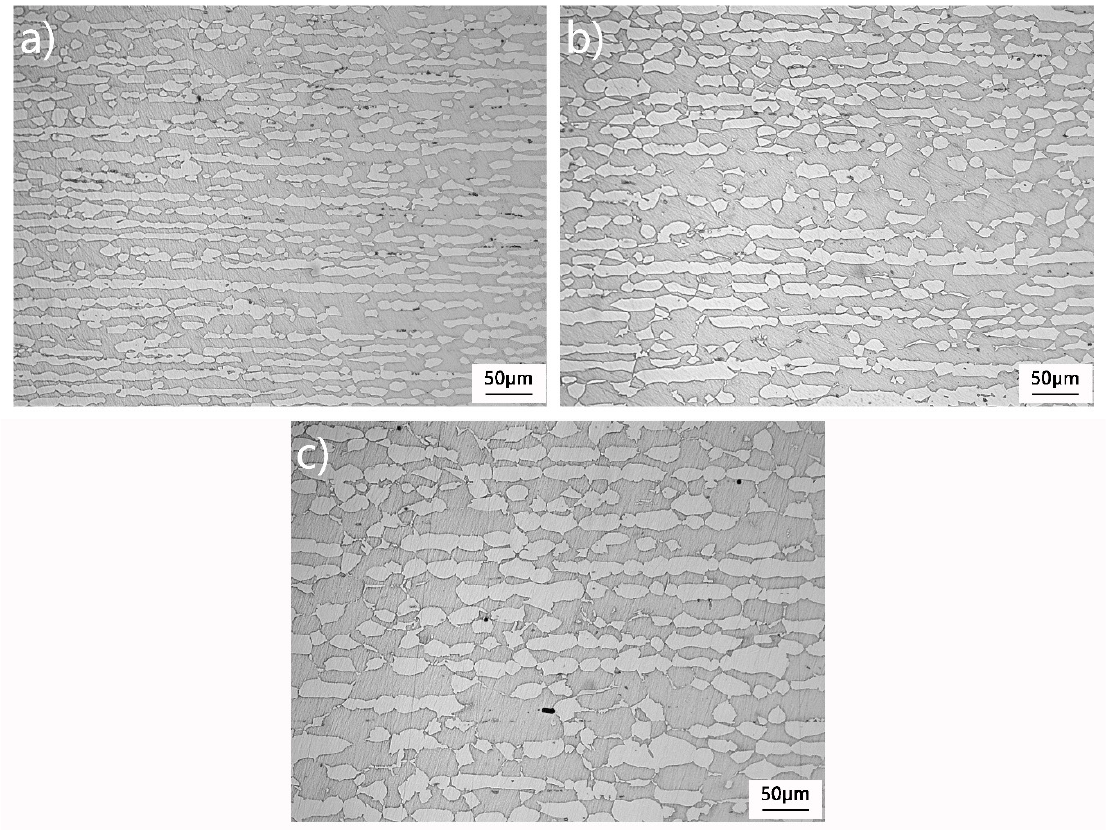
Figure 2. Microstructure of 2205 stainless-steel at different heating temperatures away from the bonding interface: ( a ) 1100 °C, ( b ) 1150 °C, and ( c ) 1200 °C.